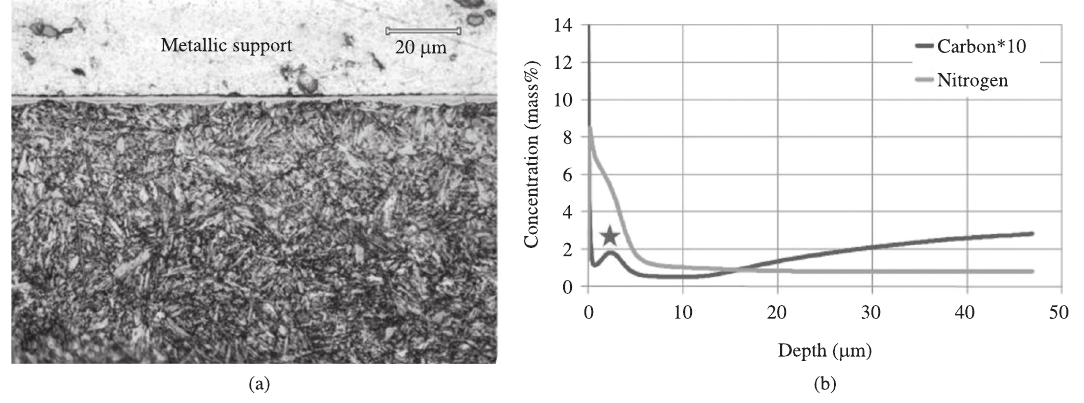
Figure 4. Sample 5N -6h. In (a) photomicrography of the cross section of the sample and in (b) GDOES 2